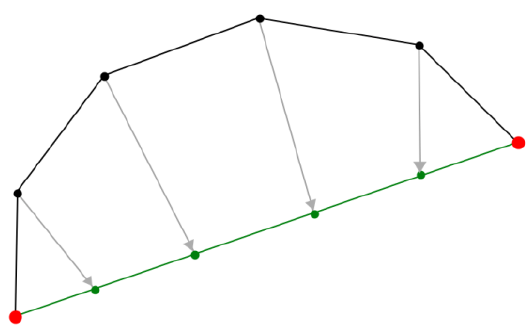
Figure 4. Alignment of the yarns’ centerline description points (vertices) between contacting points to increase the efficiency of the iterative process (red dots in this figure denote two successive contact points along a